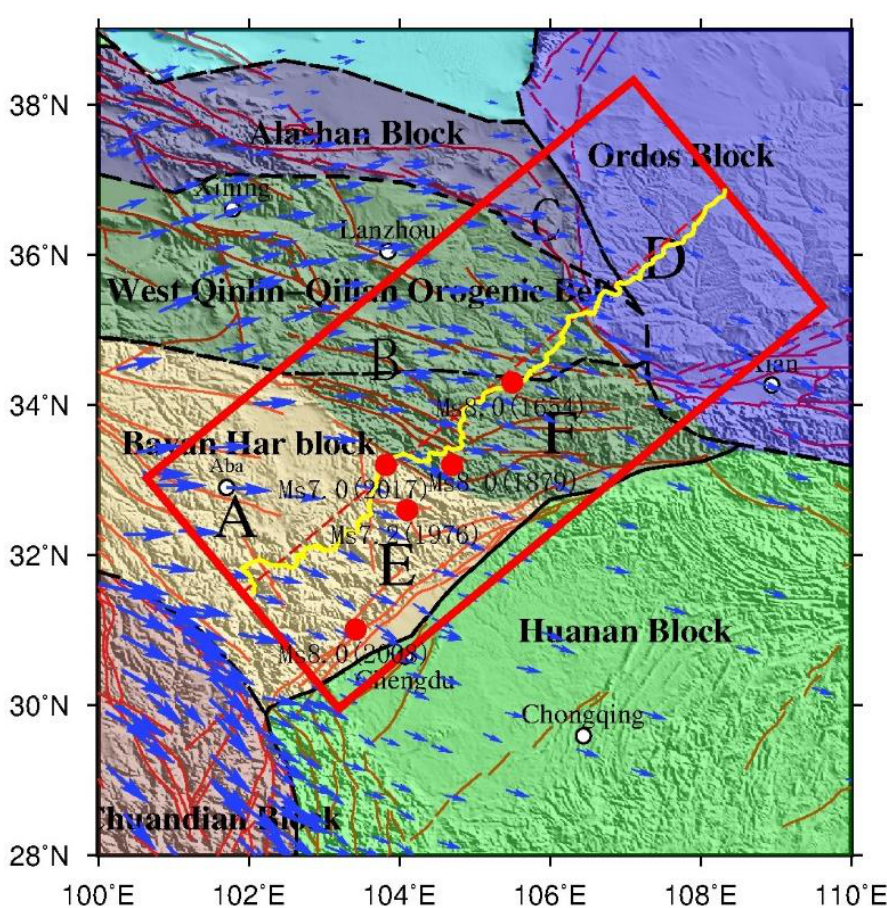
Figure 5. Velocity field of GPS observation and big earthquakes in the study area. The blue arrows represent the velocity field of GPS observation from [32]; the red rectangle denotes the study area; the yellow line represents gravity profile; the red circle represents the big earthquake (greater or equal to Ms8.0) that occurred in this area in history.